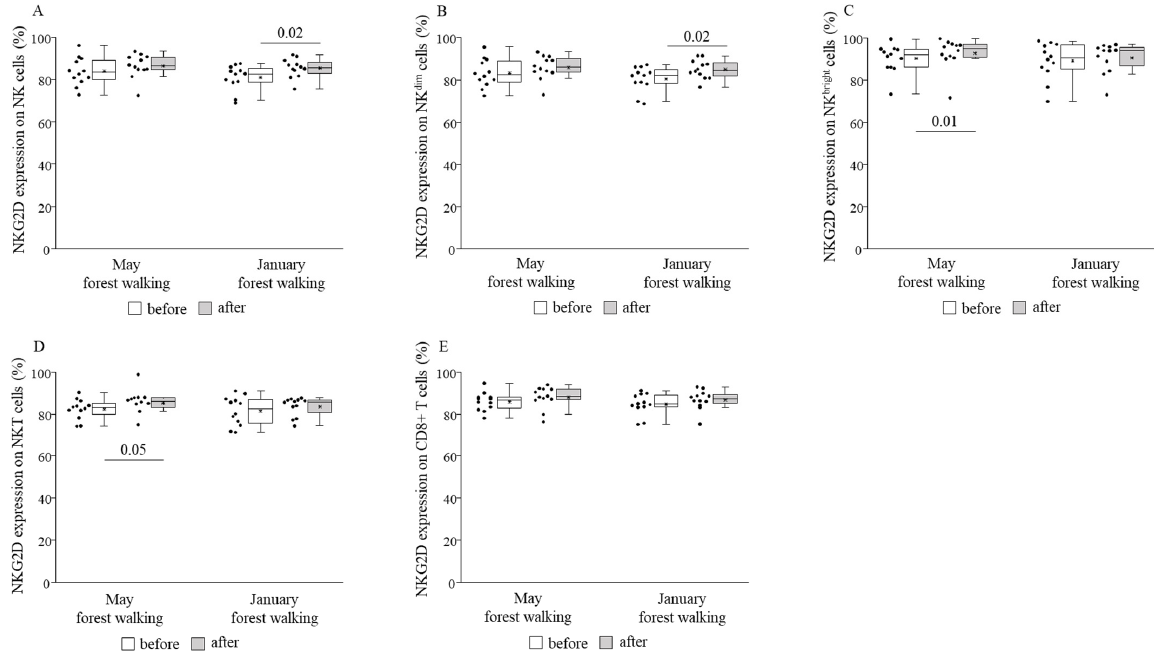
Figure 5. NKG2D expressions on total NK ( A ), NK dim ( B ), NK bright ( C ), NKT ( D ), and CD8+ T ( E ) cells prior to and following the late spring (May) and winter (January) forest walks. The middle line within the box represents the median, the middle dot within the box represents the mean, the boxes indicate the interquartile ranges between the 25th and 75th percentiles, and the whiskers show the most extreme observations in the box plot. Individual dots left from the boxes represent indi- vidual data values. Differences were considered statistically significant for p -values < 0.05. Statistically significant p -values are indicated on the horizontal lines outside the boxes. Perforin and granzyme B expressions by NK bright cells were measured to be signifi- cantly higher after the forest walk in May, and no other cell subset in either month showed any change regarding such expressions (Figures 6 and 7).